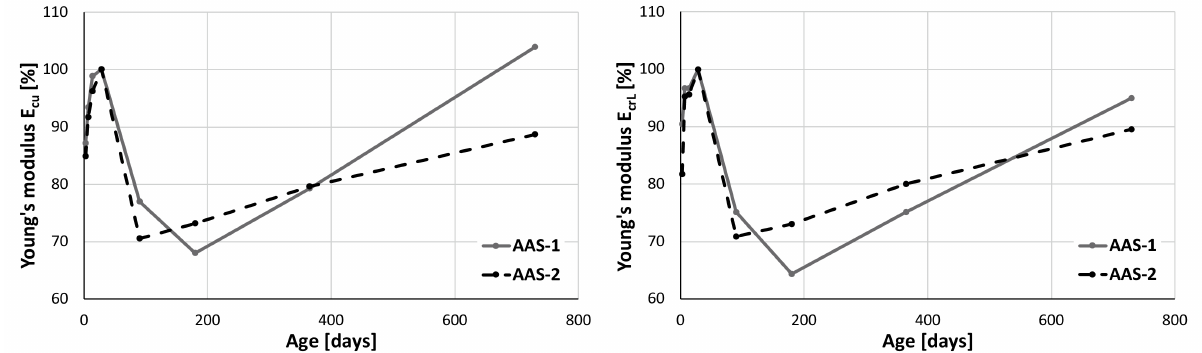
Figure 6. Development of the Young’s modulus E